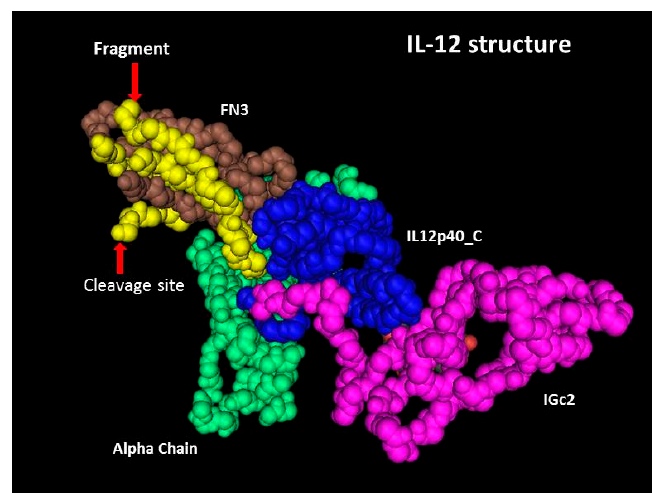
Figure 3. 3D structure of IL-12. The alpha chain (green) is subunit p35. Subunit p40 consists of three domains: FN3 (brown), rhIL-12p40_C (blue) and IGc2 (pink). The yellow region is the 5.3 kDa fragment, a part of the FN3 domain. This 3D structure was obtained from the Protein Data Bank (PDB) website (ID: 1F45).